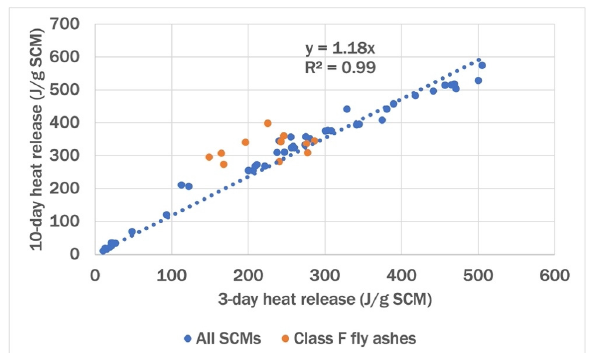
Figure 7. Relationship between 10 ‐ day and 3 ‐ day heat release in the modified R 3 test (adapted from